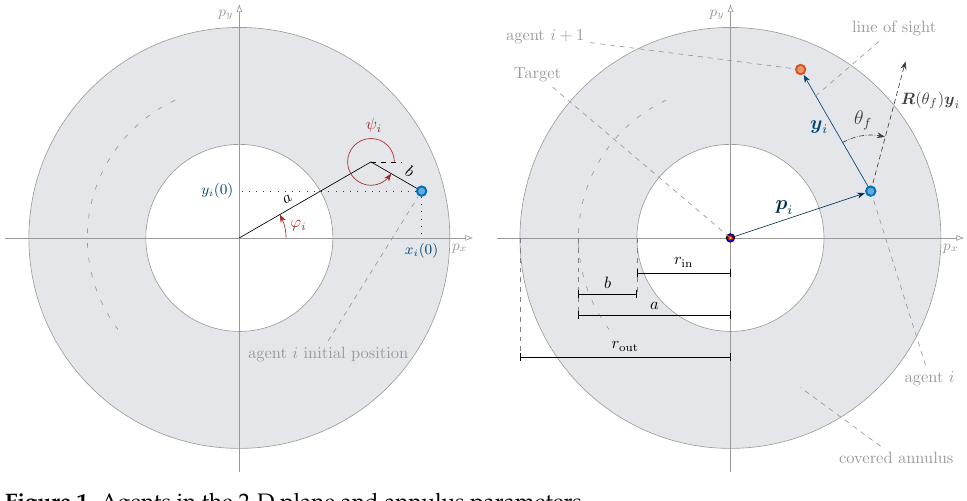
Figure 1. Agents in the 2-D plane and annulus